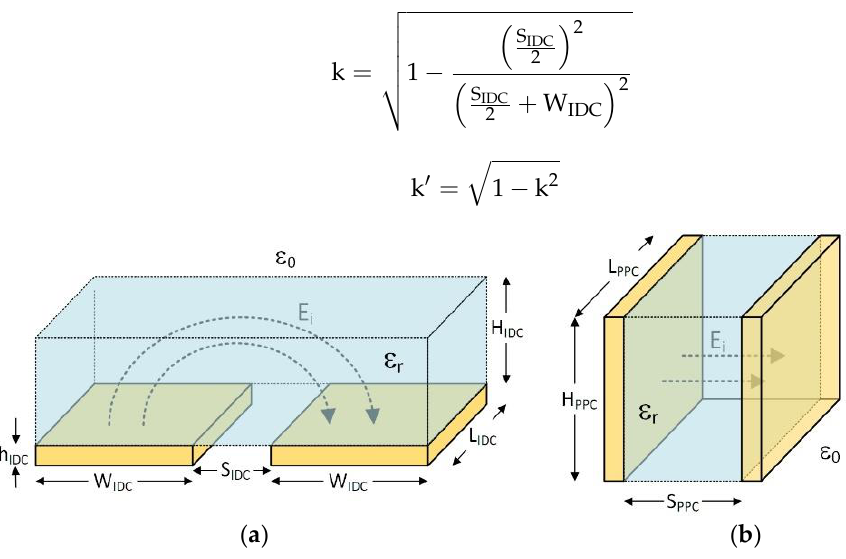
Figure 2. The dimensions used to map an ( a ) IDC structure to a ( b ) PPC structure.